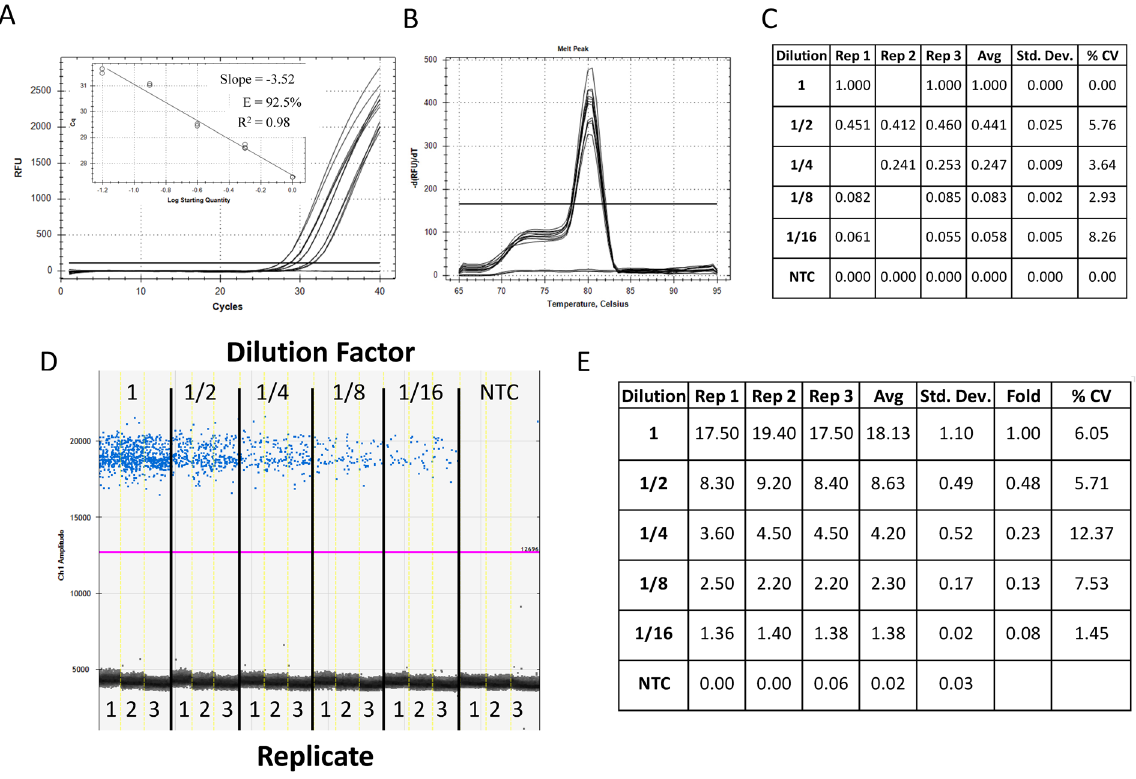
Figure 1. Assessment of primer efficiency, linear dynamic range and precision of ddPCR and qPCR platforms for low target concentration. Five reactions of 45 µ L were prepared in triplicate from 1/2 serial dilutions of synthetic DNA in nuclease-free water with primers and ddPCR EvaGreen supermix. Each reaction mix was split for quantification in qPCR and ddPCR (20 µ L for each platform). Amplification traces ( A ), standard curve (A inset), melt analysis ( B ) and tabulated relative fold difference ( Δ Cq) results ( C ) for qPCR. The ddPCR amplitude plot ( D ) and tabulated absolute concentration data ( E ). NTC: No Template Control; Dilution: Dilution factor of DNA samples; Rep: Replicate number; Avg: Average of the replicates; Std. Dev.: Standard Deviation between the replicates; % CV: % Coefficient of Variance (Std. Dev./Avg *